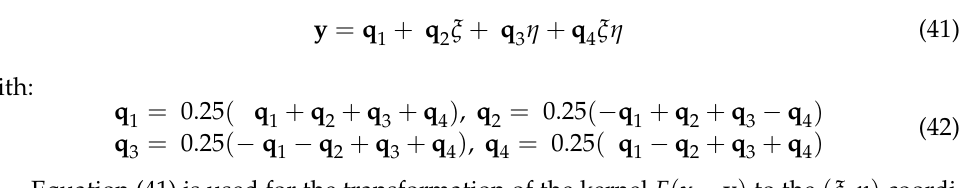
from the Cartesian coordinate system j ( ) ξ , η .